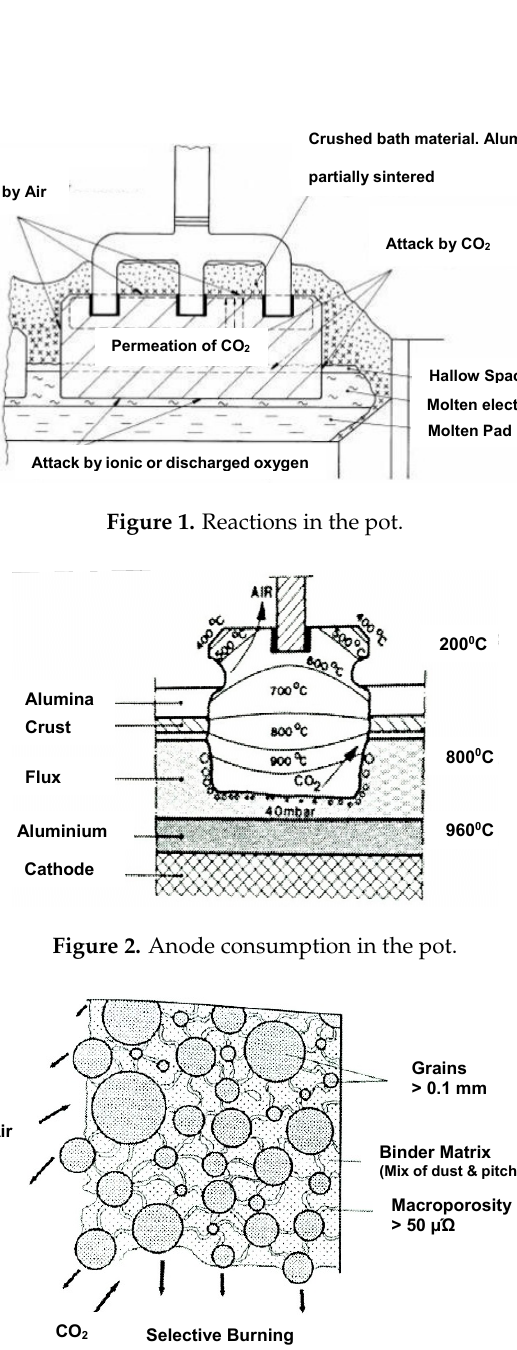
Figure 3. Selective oxidation of pitch coke.